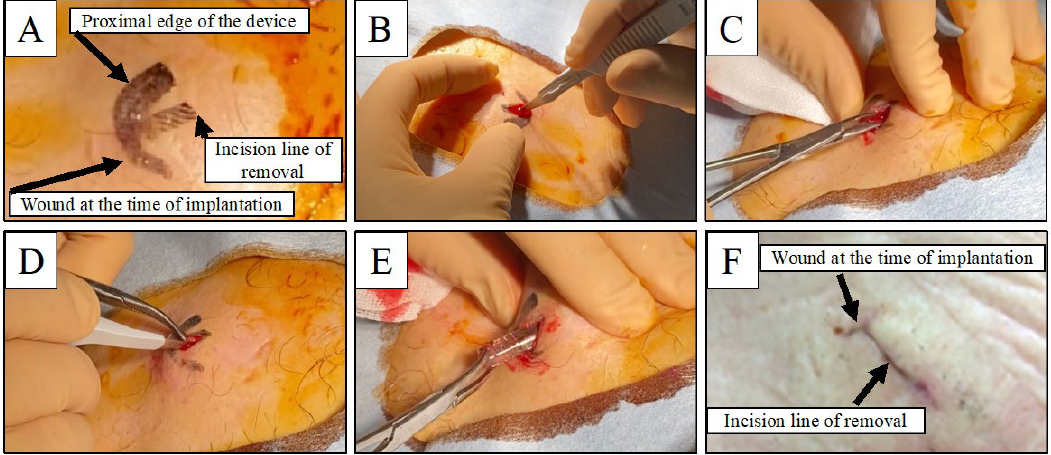
Figure 1. Intraoperative and postoperative photographs of the removal of an insertable cardiac mon- itor. ( A ) A preoperative photograph of the body surface is presented. The scar at the time of implan- tation and the proximal end of the device identified by palpation are marked. An incision line is drawn perpendicular to the implantation wound and directly above the proximal edge of the device. ( B ) A 10-millimeter incision is made in the skin. The tip of the blade should touch the proximal end of the device. ( C ) The subcutaneous tissue is removed with forceps. ( D ) When the device is covered with a capsule, the capsule is cut while the blade is placed against the device. ( E ) Once the device is visible, the proximal end is grasped with forceps and pulled out with gentle traction. ( F ) A photo- graph of the wound is shown one week after the procedure. There is no evidence of wound dehis- cence, infection, bleeding, or skin ischemia. 3. Results 3.1. Procedural Results ICM removal was successful in all cases, and no intraoperative complications were observed. One week after the procedure, no wound dehiscence, wound infection, bleed- ing, or tissue ischemia was observed in all cases. 3.2. Patients’ Characteristics The baseline characteristics of patients receiving ICM removal are shown in Table 1. Of 37 patients with ICM removal, reasons for removal were battery depletion in 65%, early removal before battery life after PAF detection in 32%, and exposure to the body surface in 3%. The median time from implantation to removal was 651 days (interquartile range: 202–1093 days). The removed devices were Reveal LINQ (Medtronic, Minneapolis, MN, USA) in 62%, Confirm Rx (Abbott, IL, USA) in 30%, and BioMonitor 2 (BIOTRONIK, Ber- lin, Germany) in 8%. Reimplantation after ICM removal was performed in two patients (5%), one for continued monitoring after battery depletion and one for reimplantation af- ter exposure to the body surface. A patient (3%) had a recurrence of cerebral infarction after ICM removal; his reason for ICM removal was battery depletion, and the type of recurrent infarction was diagnosed as lacunar infarction. Ablation of PAF was performed in one patient (3%), in whom electrocardiogram monitoring was continued after PAF de- tection until the battery was depleted.